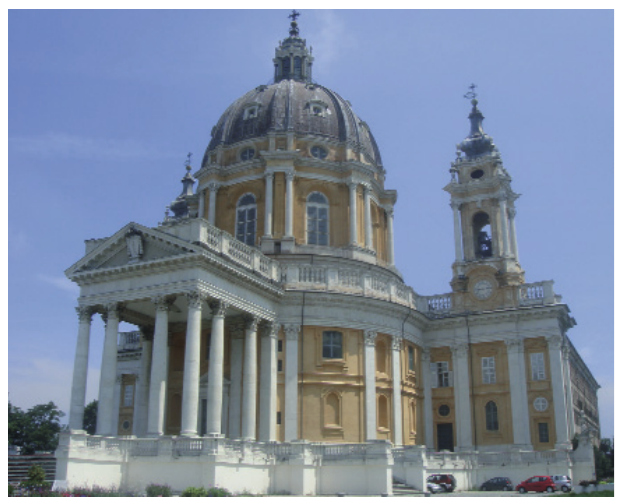
Figure 4. Ornamental stones of Piemonte: the Superga Basilica, via Roma, Turin (photo: